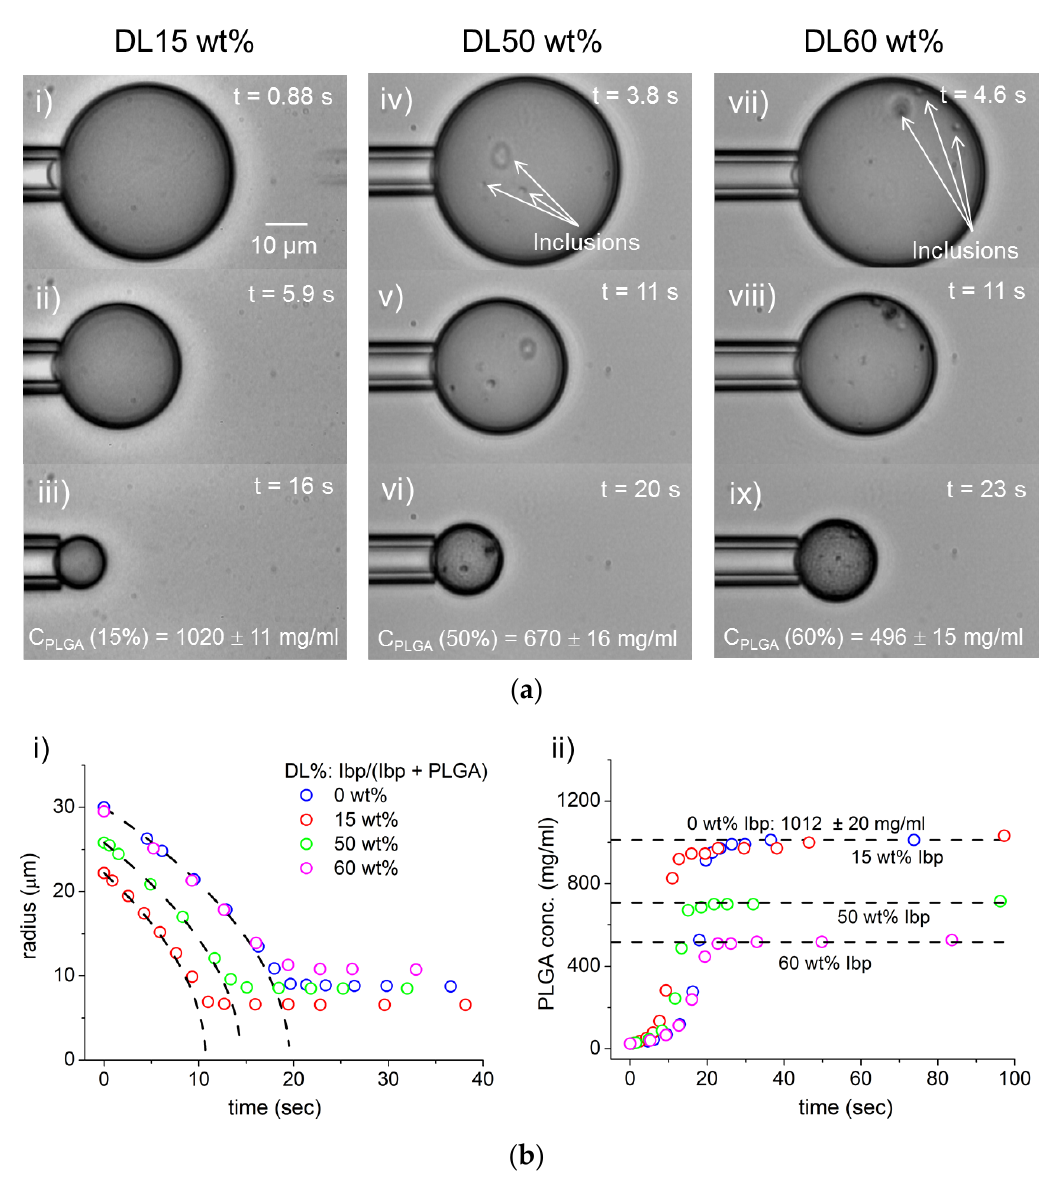
Figure 8. DCM/PLGA/Ibp solution microdroplet dissolution in PBS at room temperature. ( a ) Videomicrographs of three different PLGA microdroplets formation and precipitation with